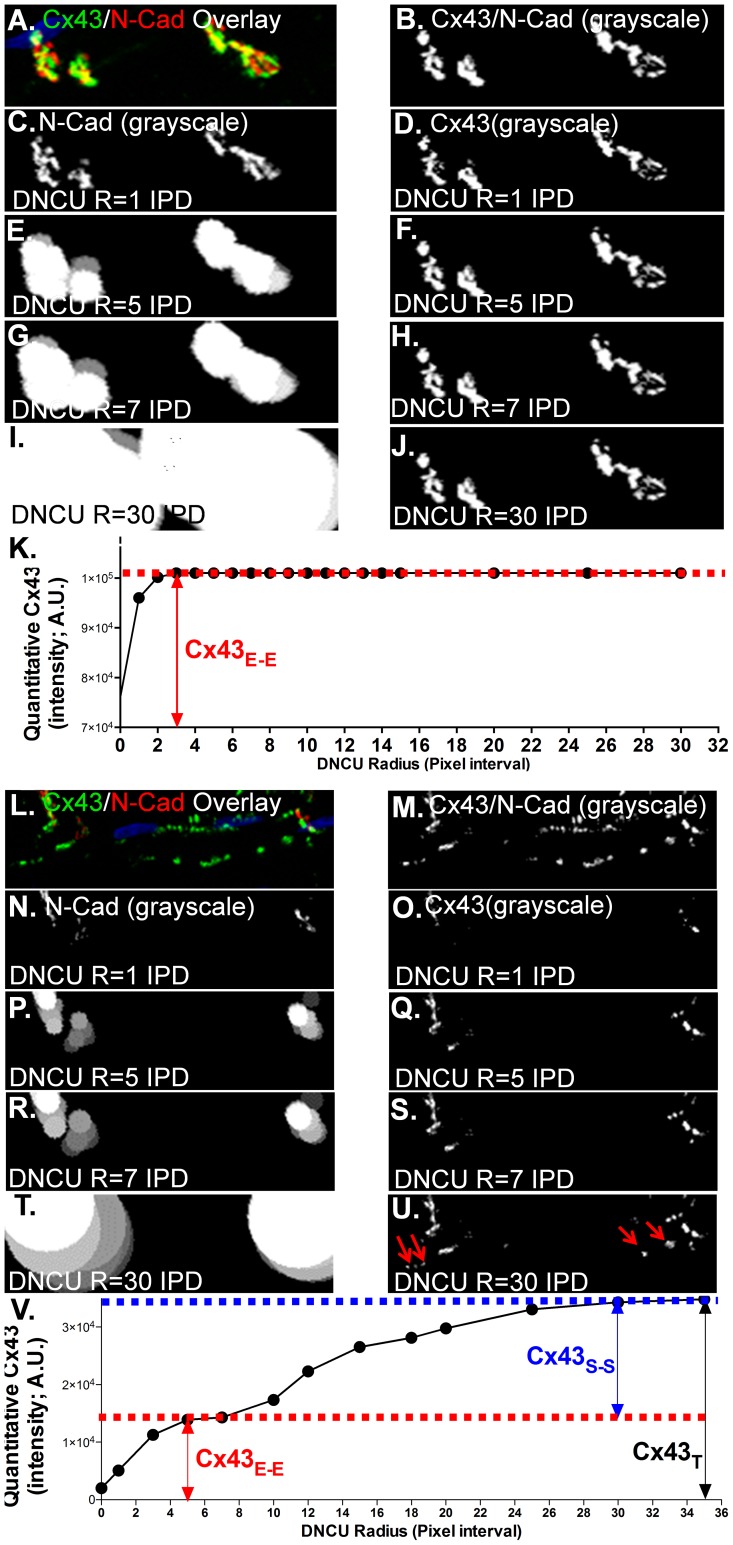
Determining an optimal radius of DNCU for Cx43E-E and Cx43S-S quantification. A-B & L-M.Representative Cx43 (green) and N-Cad (red) double immunostaining confocal images (A, L) and grayscale images (B, M) of enlarged single myocytes containing Cx43E-E only (A) or both Cx43E-E and Cx43S-S (L). C-J & N-U. Grayscale images of the enlarged single myocytes with an incrementally increased DNCU radius (1, 5, 7, 30 IPD, respectively) for both N-Cad (left column) and Cx43 (right column). Arrows (U) indicate the inclusion of lateralized Cx43 by an extensively enlarged radius of the DNCU. K & V. Summarized data of quantitative Cx43 values corresponding to a continuously increased radii of DNCU when myocytes present Cx43E-E only (K) or present both Cx43E-E and Cx43S-S (V). The Y-axis value of the first plateau reflects quantitative amount of ID located Cx43E-E (red label) and the difference of the Y-axis value between the first and second plateaus indicates the amount of lateralized Cx43S-S.